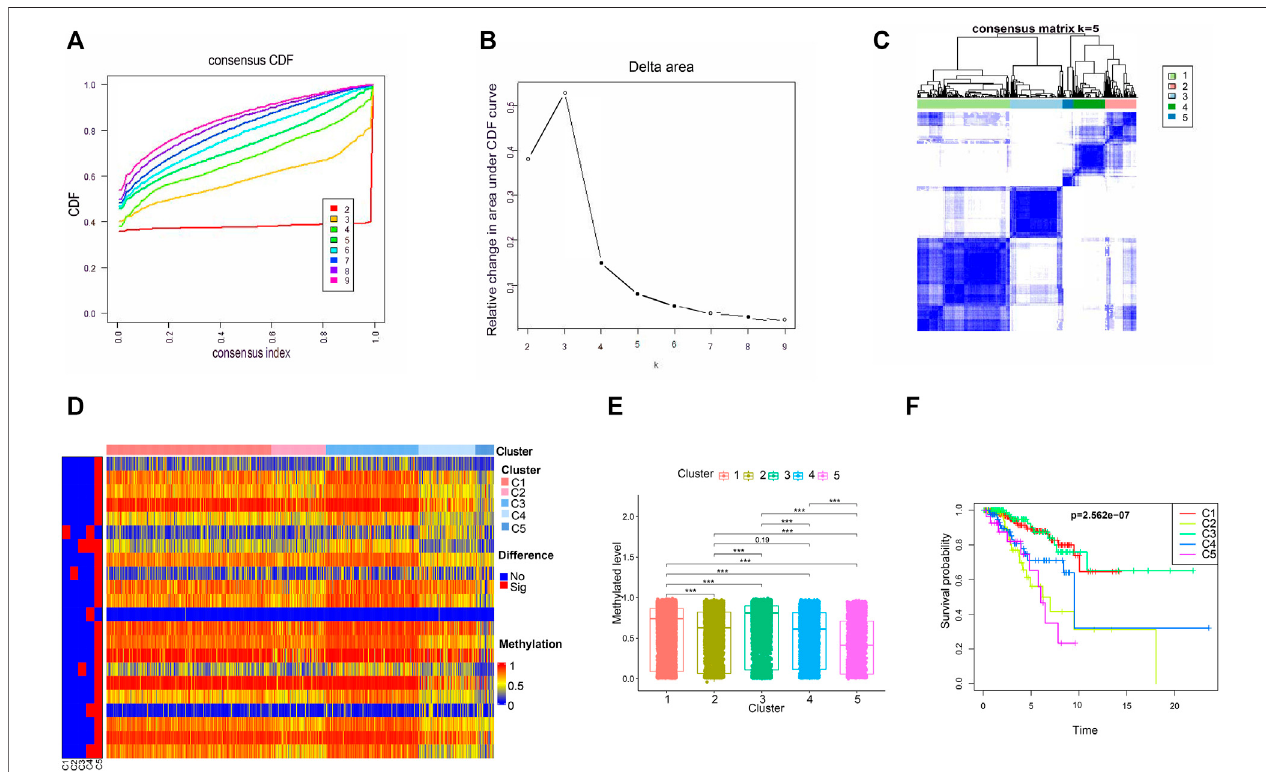
FIGURE3| Themethylatedlevelsandprognosisofconsensusclusteringsubgroupsofbreastcancer. (A,B) Consensusclusteringcumulativedistribution function fork (cid:1) 2 – 9. (C) Consensusclusteringmatrixfork (cid:1) 5. (D) Heatmapofthedifferentiallymethylatedlevelsofthe fi vesubgroups. (E) Methylatedlevelsofthe66independent prognosis-related CpG loci among the fi ve clusters. (F) Survival analysis of the fi ve subgroups.